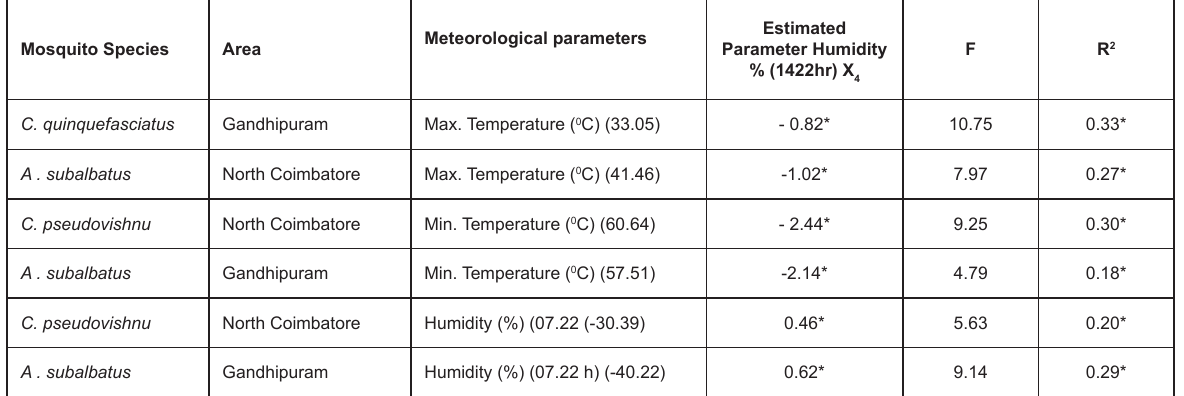
Table 1. Correlation between mosquito populations and meteorological